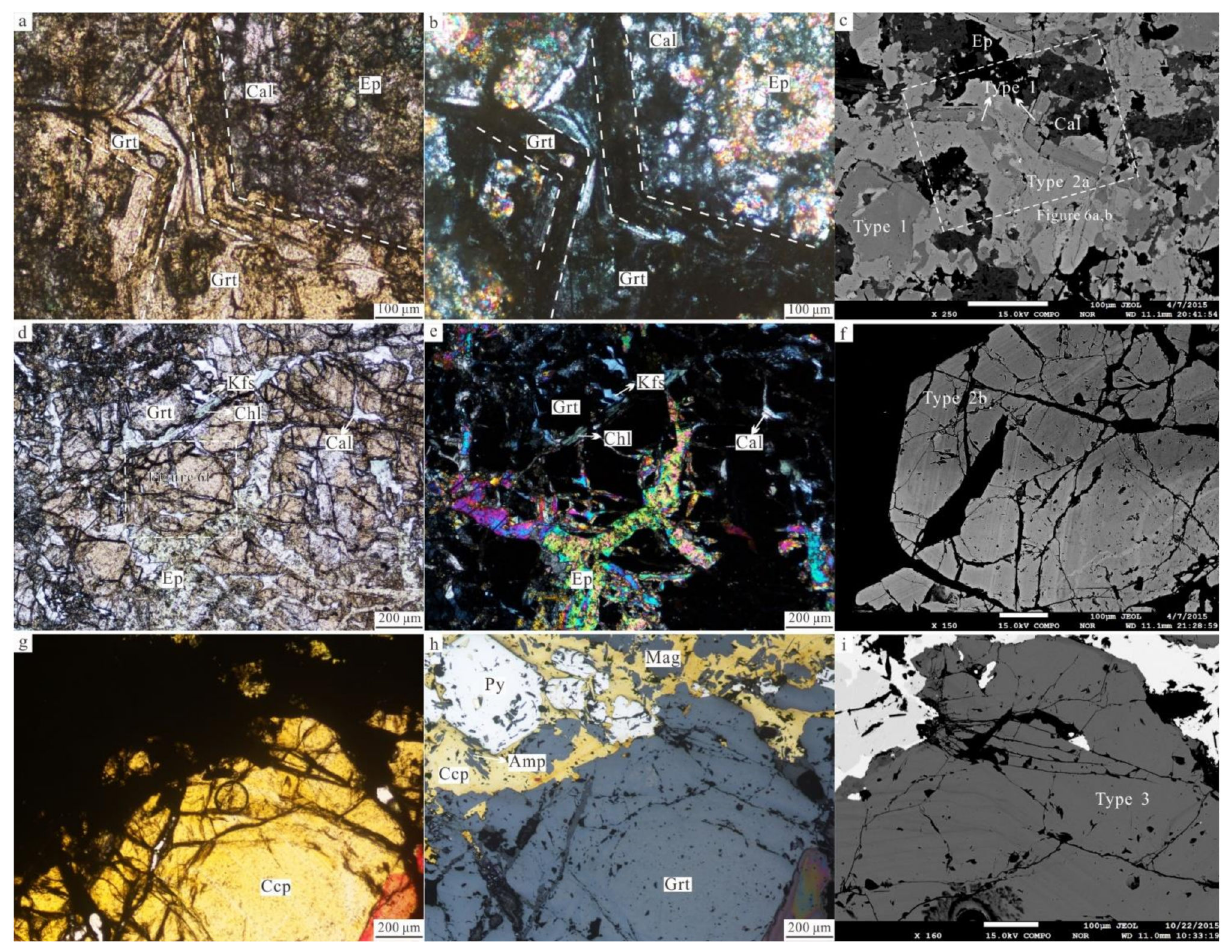
Figure 6. Transmitted-reflected light photomicrographs and BSE images of garnets from the Laoshankou deposit. ( a , b ) Type 1 brown garnet is corroded by subsequent Type 2a garnet, epidote and calcite; ( c ) Type 1 and Type 2a garnets with different BSE extinction; ( d , e ) Type 2 dark red garnet coexists with K-feldspar and is cut by subsequent epidote, calcite and chlorite; ( f ) unobvious oscillatory zoning in fine-grained Type 2b garnet; ( g ) Type 3 yellow-green garnet with obvious coarse-grained texture; ( h ) yellow-green garnet coexists with chalcopyrite, quartz, amphibole and chlorite; ( i ) homogeneous Type 3 garnet crystal. Abbreviations: Amp, amphibole; Cal, calcite; Ccp, chalcopyrite; Chl, chlorite; Ep, epidote; Grt, garnet; Kfs, K-feldspar; Mag, magnetite; Py,